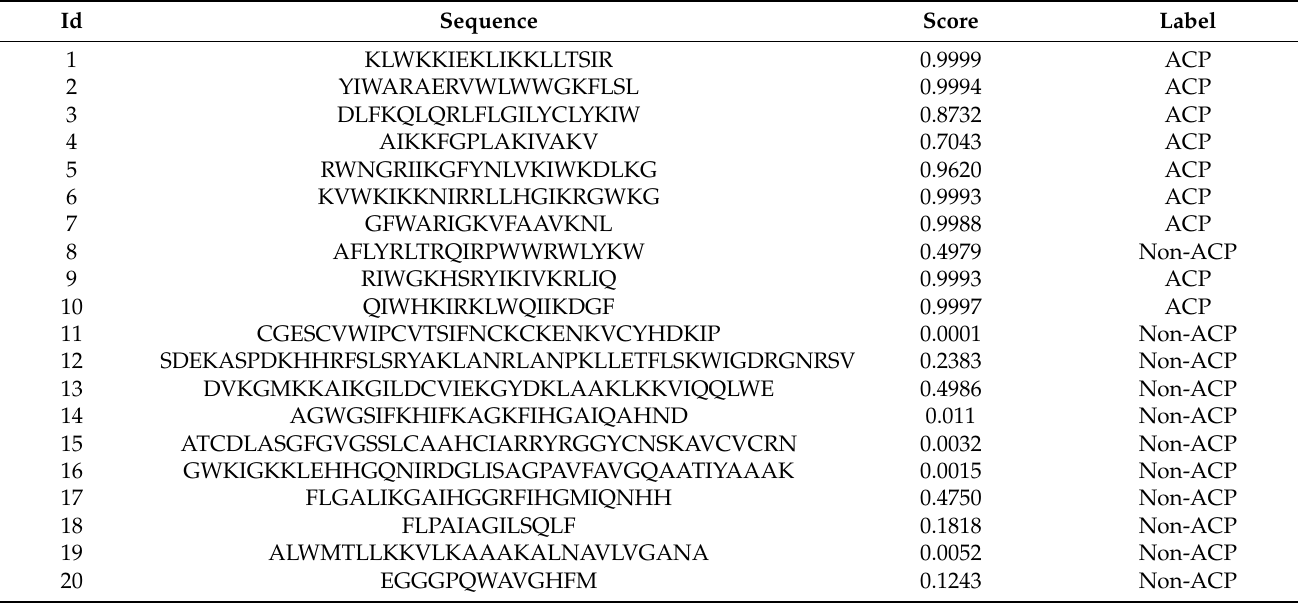
Table 6. The independent validation results of